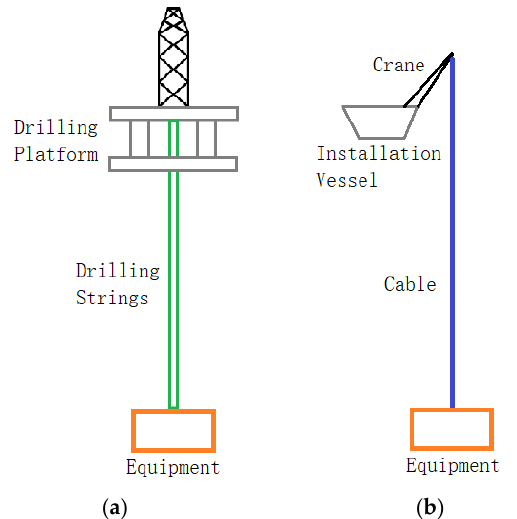
Figure 1. Schematic diagram of installation methods for subsea equipment: ( a ) installation with drilling strings; ( b ) lifting installation method.